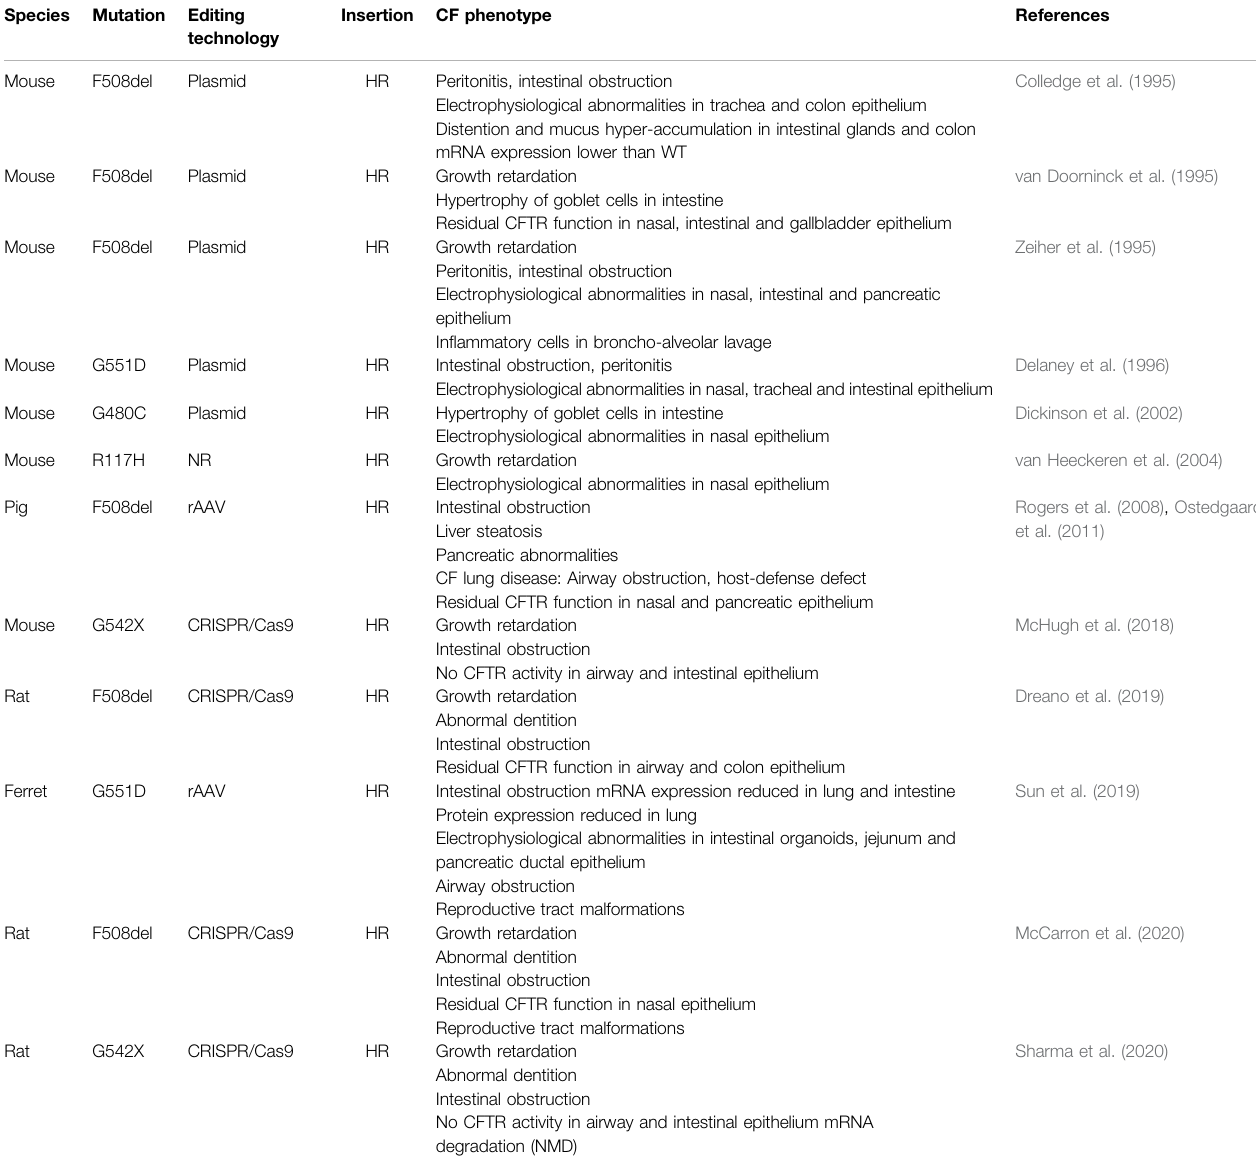
TABLE 1 | Knock-in CF animal models. Species Mutation Editing Insertion CF technology